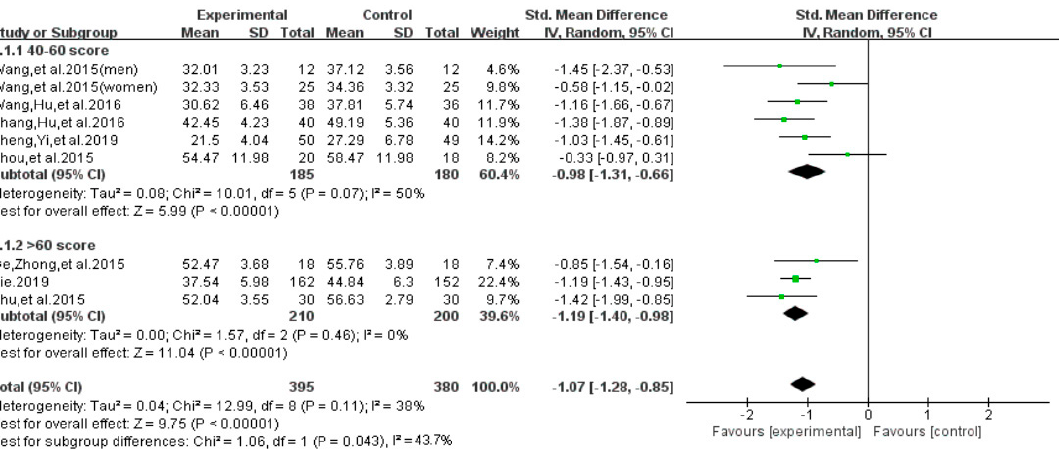
Figure 13. Effect of intervention duration on smartphone addiction patients.